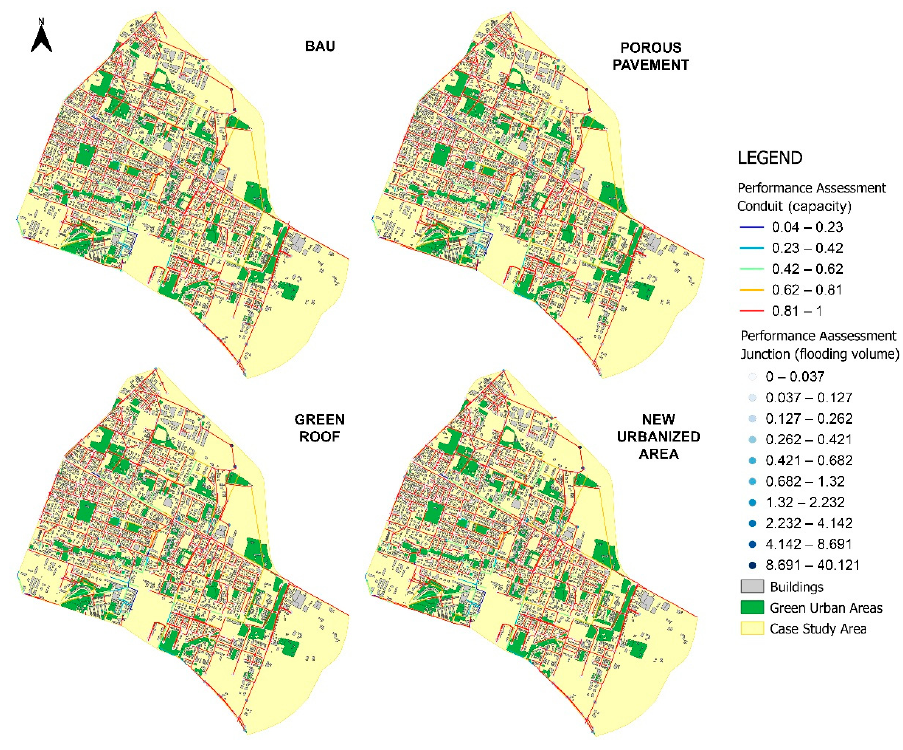
Figure 9. Comparison of the four scenarios.